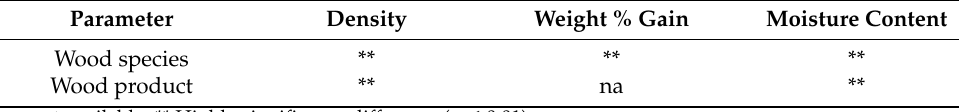
Table 3. Duncan’s multi-range test of physical